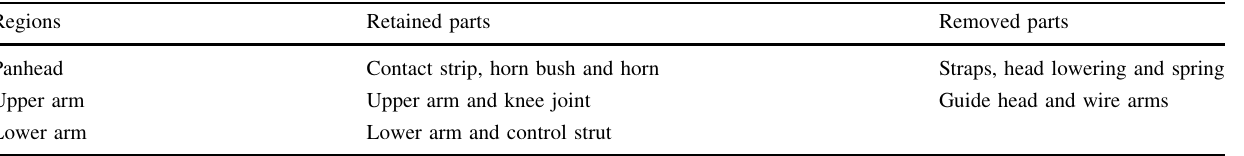
Table 4 List of retained and omitted